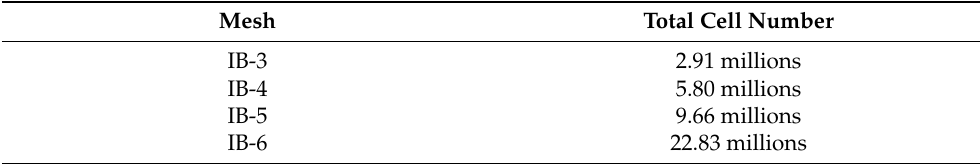
Table 2. Total cell numbers of the grids with different numbers of refinement